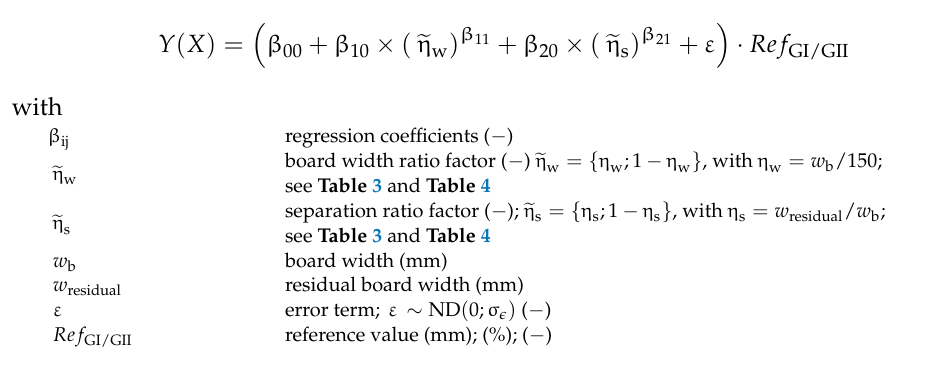
Table 3. Regression coefficients, standard deviations of the error term, and reference values of the regression models for the description of the expected values, coefficients of variation, and equi- correlation coefficients for all six geometric variables and reference values of GI and